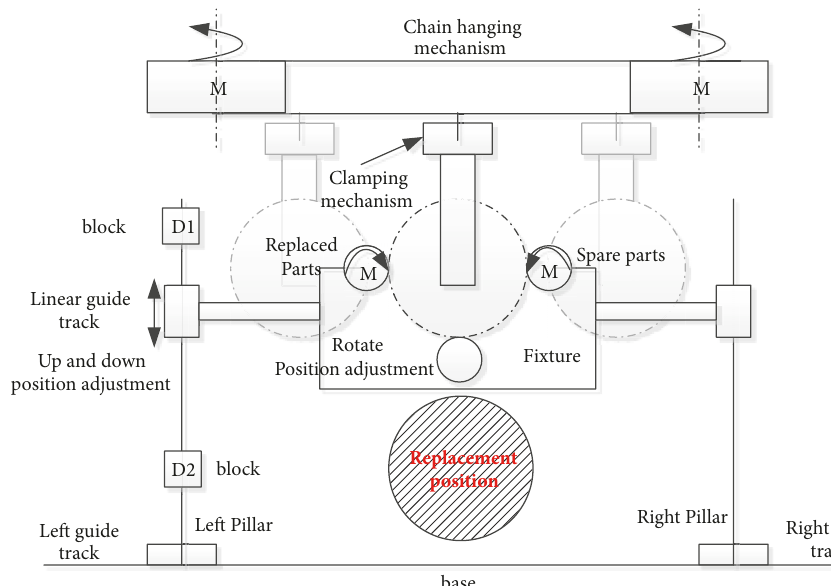
Figure 12: A schematic diagram of replacement device for vulnerable parts.